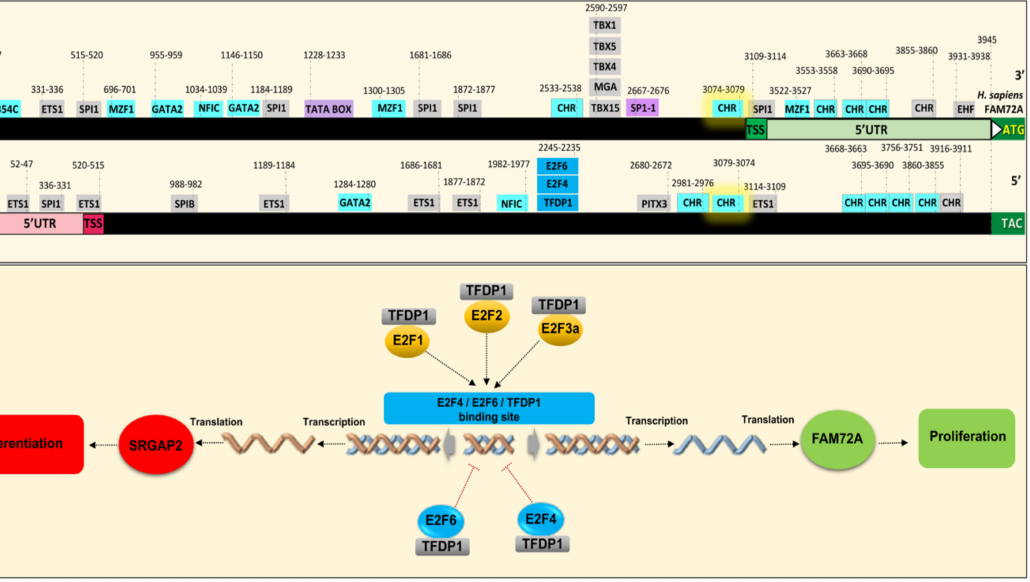
Figure 5. Integrated diagram for putative TFBSs in the intergenic region IGR between the transcription start sites (TSS) of FAM72A and SRGAP2, using the Ensembl and JASPAR databases, and the effect on the cell cycle. ( a ) Putative TFBSs on the IGR between SRGAP2 and FAM72A coding sequences in Homo sapiens . Multiple TFBSs are present for binding of the TFs GATA2, SPI1, MZF1, EGR1, SP1, and E2Fx (x = 1, 2, 3, 4 and 6). The open reading frames (ORFs) for FAM72A and SRGAP2 are indicated on the right and left sides, respectively. TFs that are common between FAM72 (A–D) and selected M-phase cell cycle genes are in pale blue. Investigation of the potential TFBSs on the IGR shows that FAM72A is a cell cycle gene particularly active in mitosis and under control of the DREAM and MMB-FOXM1 complexes acting on the CHR BS to regulate |-SRGAP2–FAM72A-|. The DREAM complex is composed of TFDP1, RBL2, or RBL1, the repressor E2F TF E2F4 or E2F5 and the MuvB core complex (containing LIN9, LIN37, LIN52, RBBP4 (LIN53), LIN54). The MMB–FOXM1 complex is composed of the MuvB complex (dissociated from the DREAM complex), MYBL2, and FOXM1. Notably, the CHR site (pale blue) located next to the TSS of the FAM72A gene has the highest potential to be targeted for driving FAM72A gene expression. ( b ) The crucial E2F4/E2F6/TFDP1 BS in cell fate decision. The consensus E2F4/E2F6/TFDP1 BS within the IGR could become occupied by an E2Fx family member depending on cell demand during specific cell phase stages and may be crucial for cell fate decision to activate either FAM72A (for cell proliferation and renewal) or SRGAP2 (for neural differentiation). Chr, chromosome; CHR, Cell cycle gene homology region; E2F1/2/3/4/6, E2 factor TF 1/2/3/4/6; EGR1, early growth response 1; EHF, ETS homologous factor; ETS1, E26 transformation specific proto-oncogene 1; GATA2, GATA binding protein 2; MGA, MAX dimerization protein; MZF1, Myeloid zinc finger 1; NFIC, Nuclear factor I C; SP1-1, Specificity protein 1 TFBS 1; SPI1, Spleen focus forming virus proviral integration oncogene 1; TBX15/TBX1/TBX4, T-box TFBS 15/1/4; TFDP1, TF dimerization partner 1; ZNF345C, Zinc finger protein